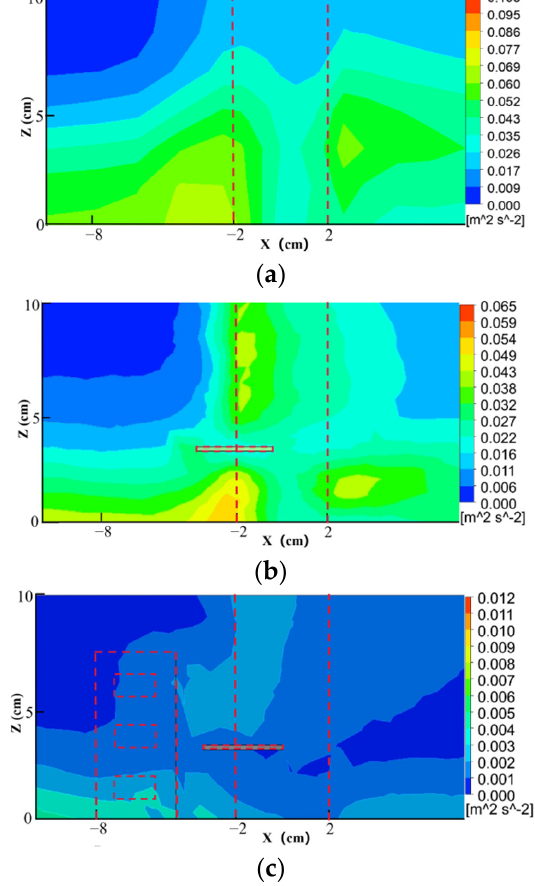
Figure 19. Turbulence kinetic energy at Y = − 2 cm. ( a ) Single pier; ( b ) Pier with ring-wing plate; ( c ) Pier with combined device.